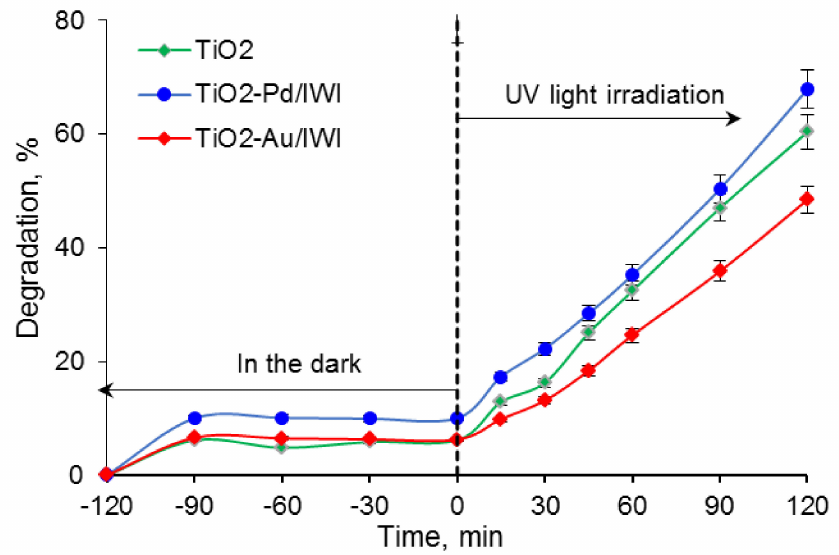
Figure 8. 2,4 DNP degradation in aqueous solution in the presence of the TiO 2 -Acros, TiO 2 -Pd and TiO 2 -Au catalysts obtained by the IWI